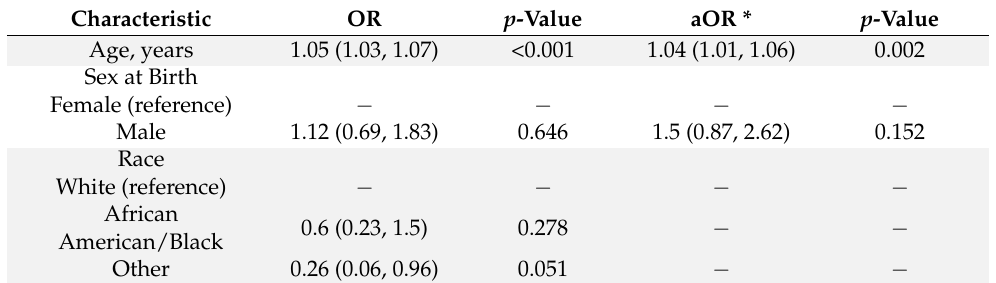
Table 2. Factors associated with hospitalization among persons living with HIV with